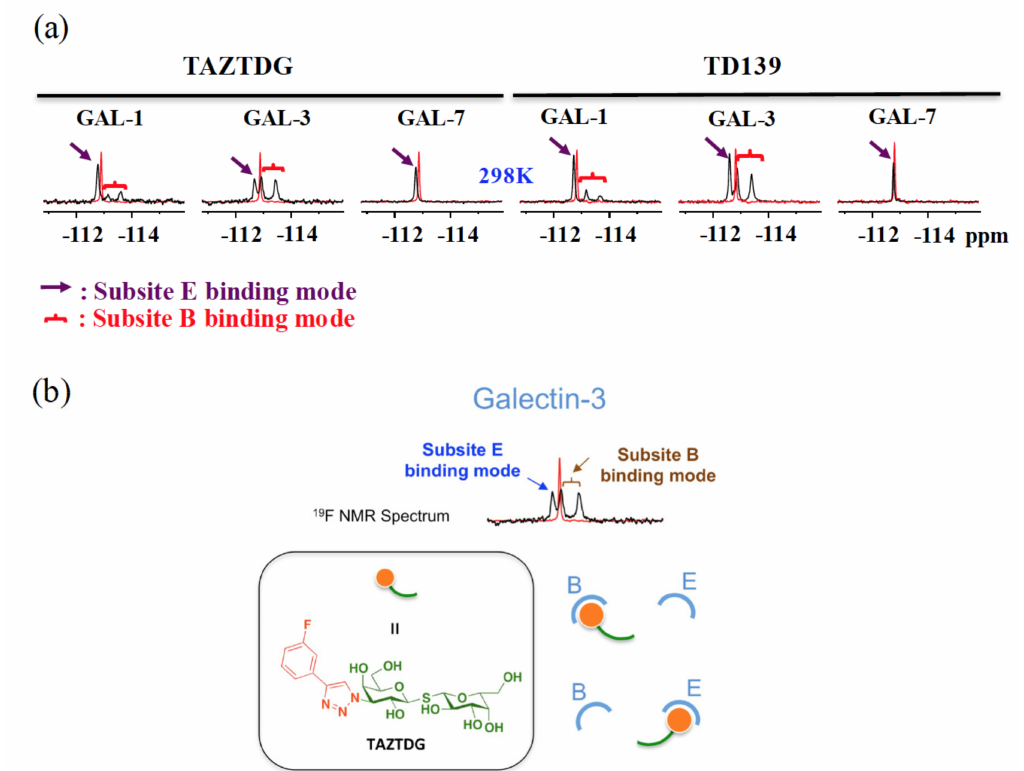
Figure 14. ( a ) 19 F-NMR spectra of TAZTDG and TD139 in complex with GAL-1, -3, and -7. ( b ) Dual binding modes of the galectin inhibitor TAZTDG. On the basis of the integrated analysis of isothermal titration calorimetry, X-ray crystallography, and NMR spectroscopy, the 4-fluorophenyl-triazole moiety of TAZTDG can bind with either subsites B or E, leading to the observed dual binding modes.